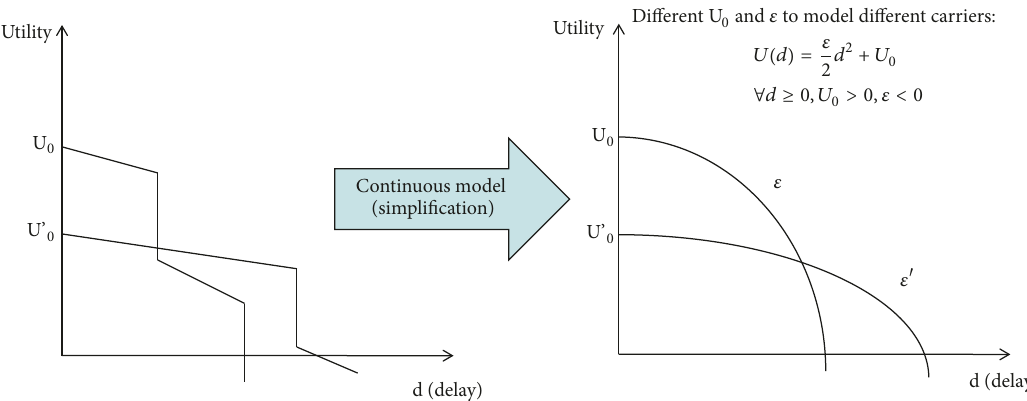
Figure 16: Approximation of the utility function as a continuous quadratic